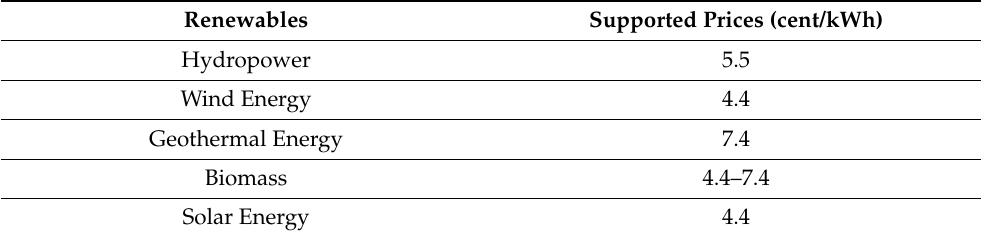
Table 4. Supported minimum prices from the Turkish government for